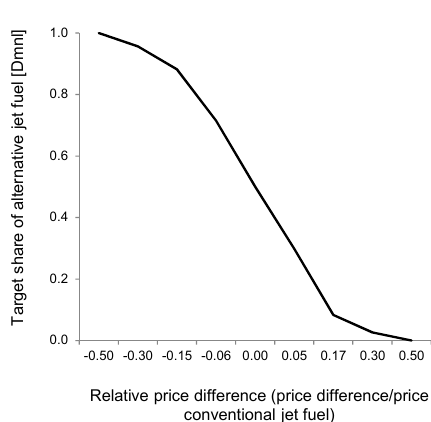
Figure 2. Table function for the effect of relative price difference between conventional and alternative fuel on target share of alternative jet fuel.